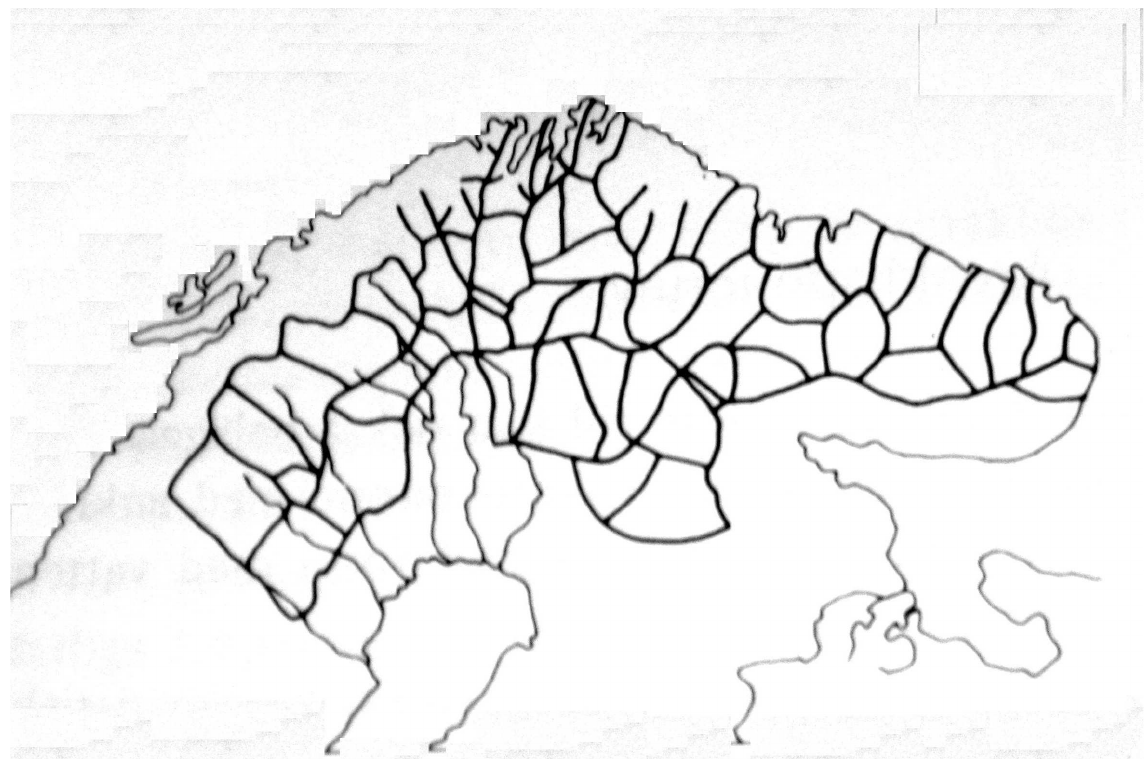
Fig. 2. Sami (“Lapp”) villages during the second half of the 16 th century (Vorren, 1980). Russia. Therefore the tax burden on the Sami was not heavy. The normal tax was 40 squirrel furs or one pelt of marten per family and year. If the state wanted more furs it had to buy them. The furs were bought by the bailiffs, the transactions were registered and the records were carefully checked by superior authorities. Furs were generally paid with butter and flour. We have reliable registers of how much foodstuff the bailiffs handed over to the Sami as payment for furs. 3 The amounts were considerable. Furthermore the Sami sold furs to Swedish, Karelian and Russian traders. foodstuff to the